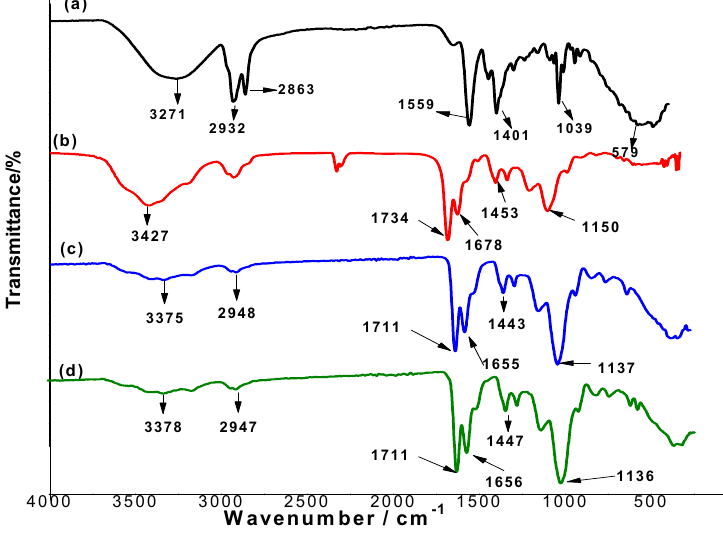
Figure 2. Fourier Transform-Infrared (FT-IR) spectra for ( a ) NaDC, ( b ) NaDC / MIP, ( c ) washed MIP and ( d ) NIP beads.